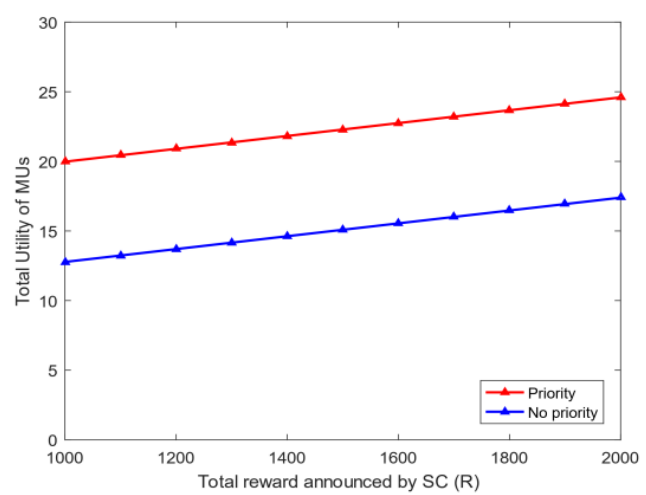
Figure 7. Changes in total utility and R of MUs whether choosing priority.